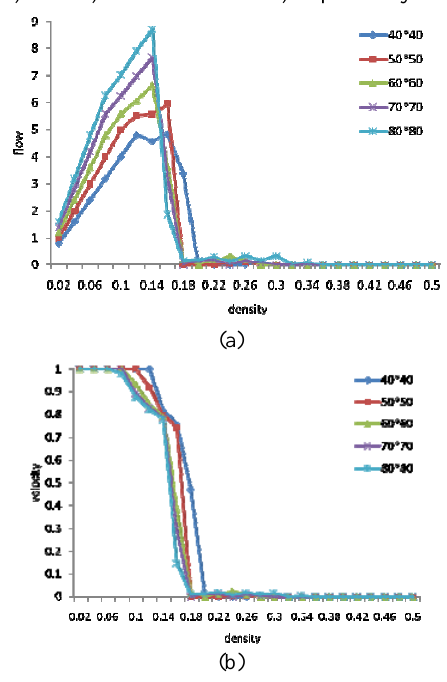
Fig. 8. The flow rate <f> against velocity <v> with various channel sizes. Here, the paired rate is set as 0.5.